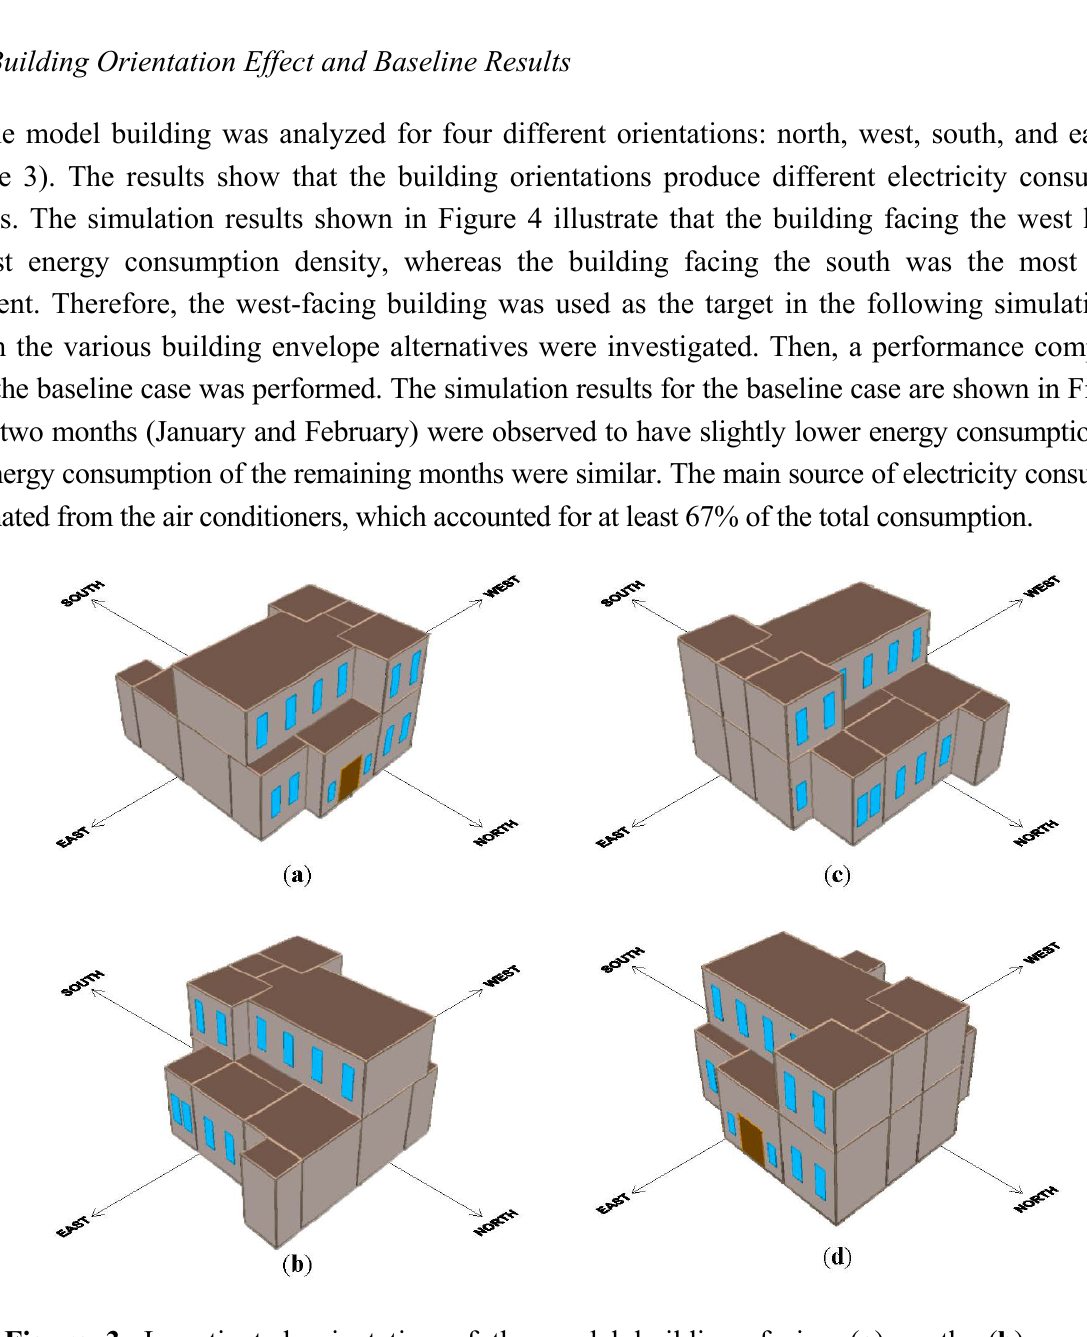
Figure 3. Investigated orientation of the model building: facing ( a ) north; ( b ) west; ( c ) south; and ( d )